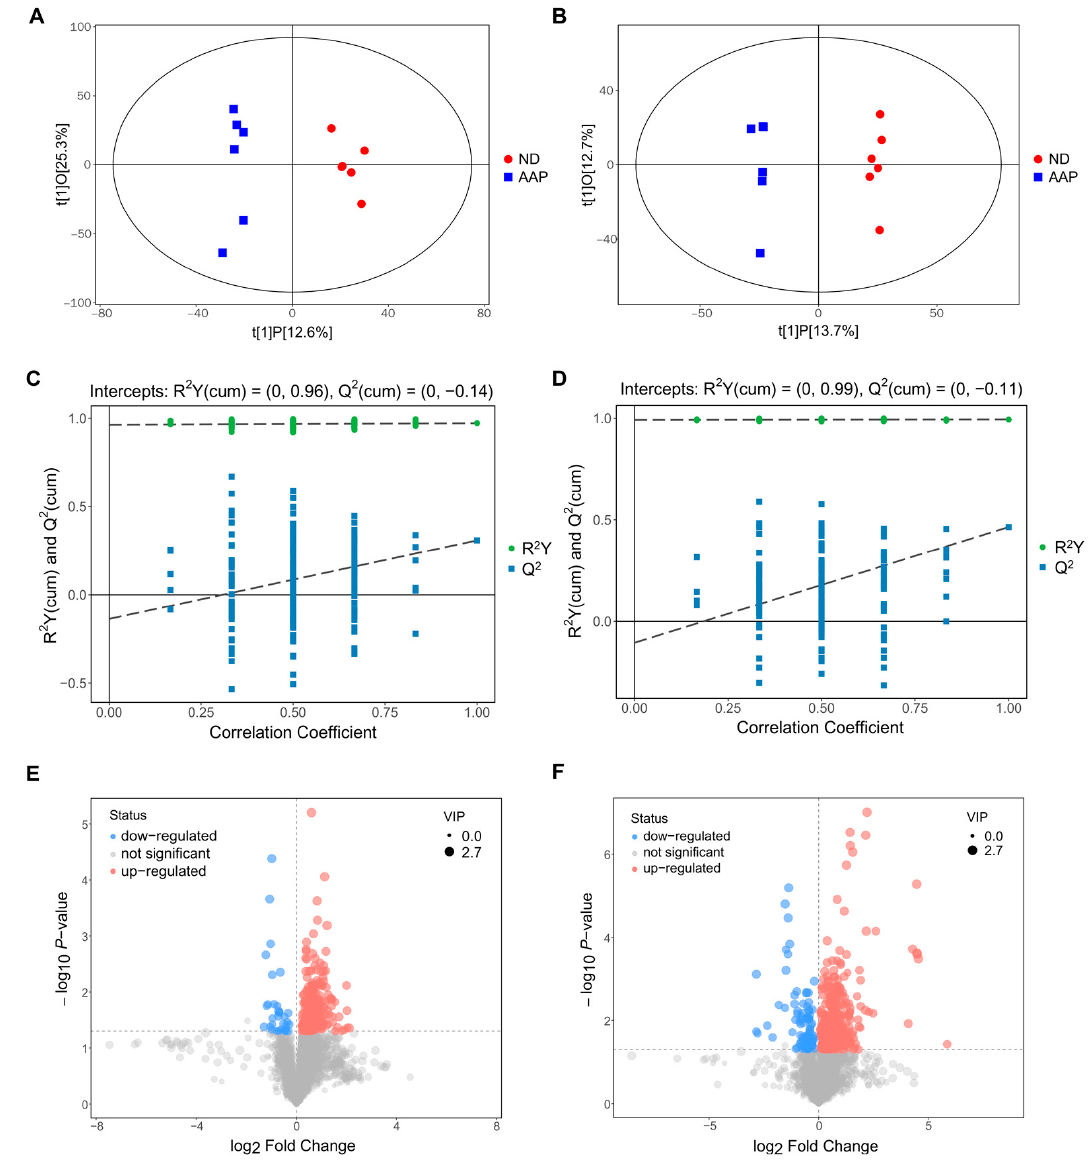
Figure 3. Biomarkers identification after Auricularia auricula polysaccharides consumption by serum metabolomics. OPLS-DA score plot in ( A ) positive ion mode; ( B ) negative ion mode; OPLS-DA replacement test (200 times) in ( C ) positive ion mode; ( D ) negative ion mode; The slope of R 2 is greater than 0, and the intercept of Q 2 on the Y axis is less than 0.05, indicating that the model is effective; Volcano map of differential metabolite screening in ( E ) positive ion mode; ( F ) negative ion mode. ND = normal diets; AAP = Auricularia auricula polysaccharides. Data presented as mean ± SD, n = 6.